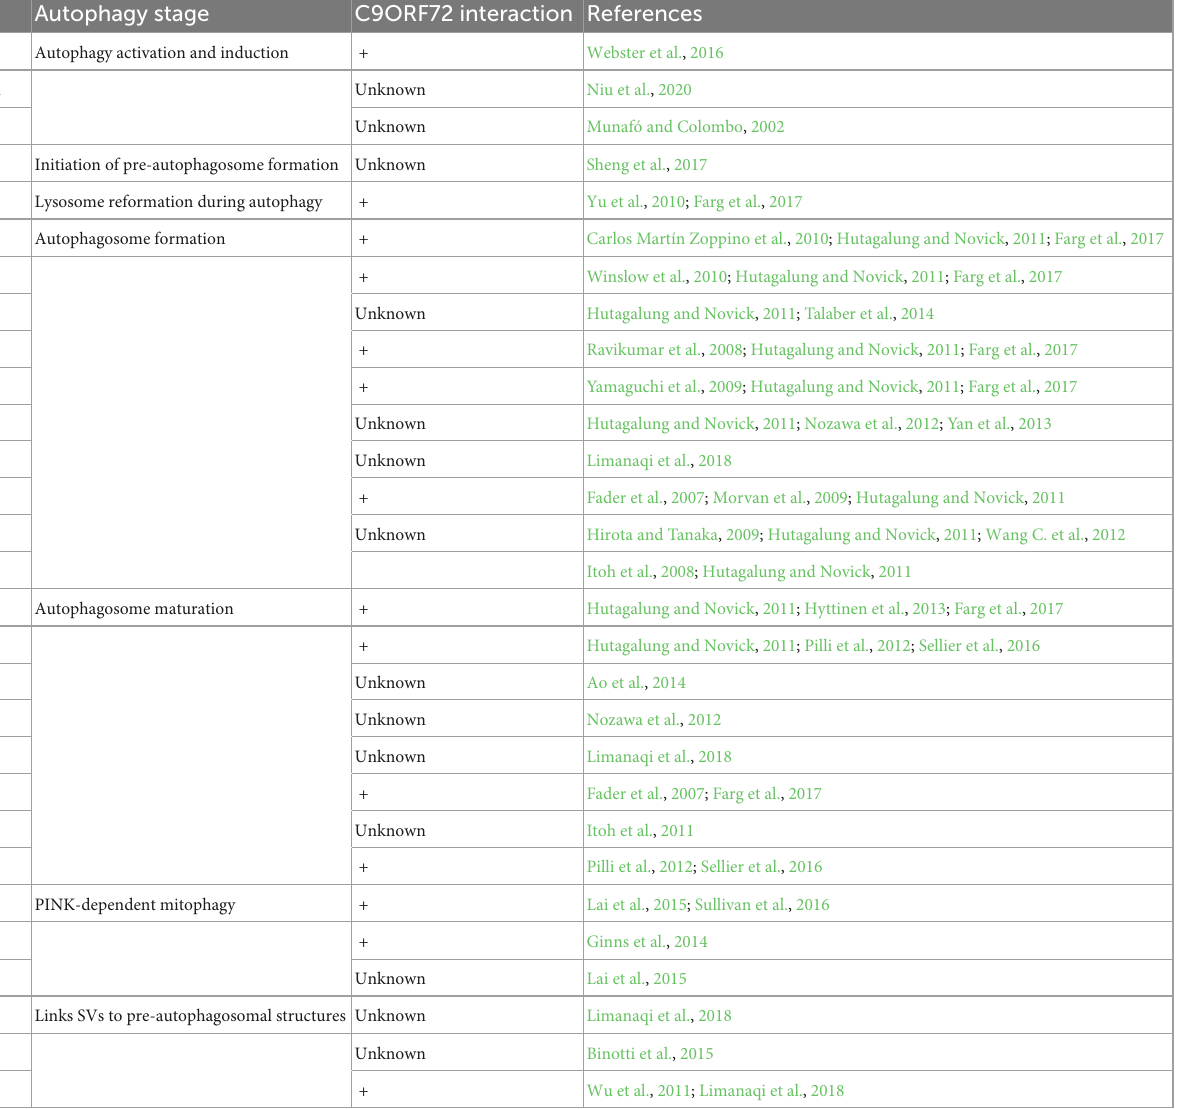
TABLE 1 List of RAB proteins involved in the autosomal-lysosomal pathway (ALP).